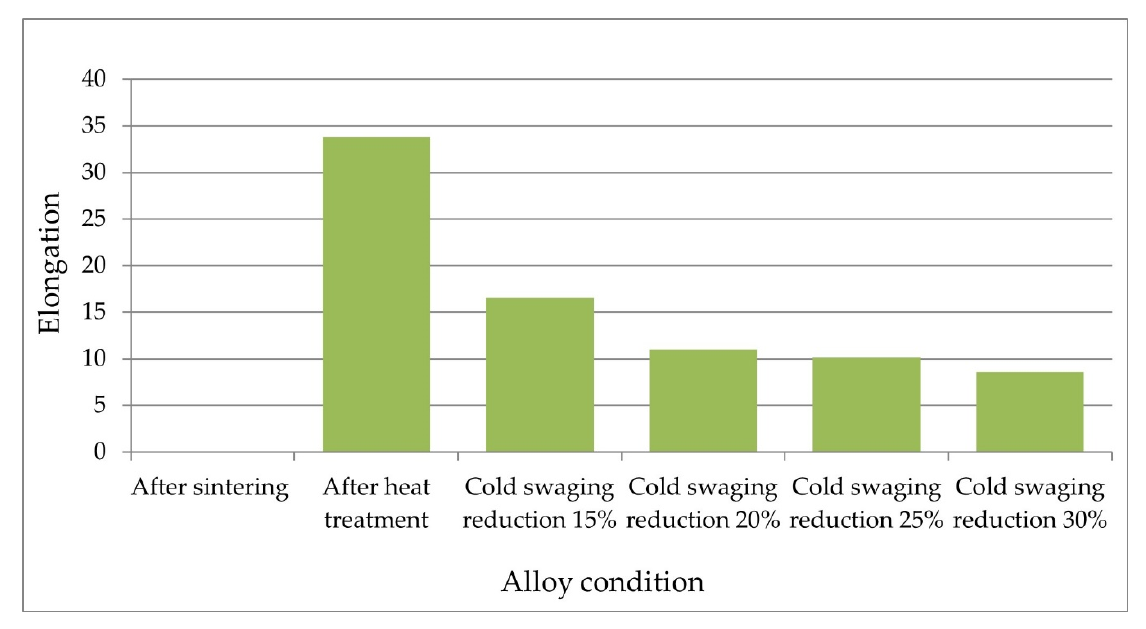
Figure 8. Elongation test results.